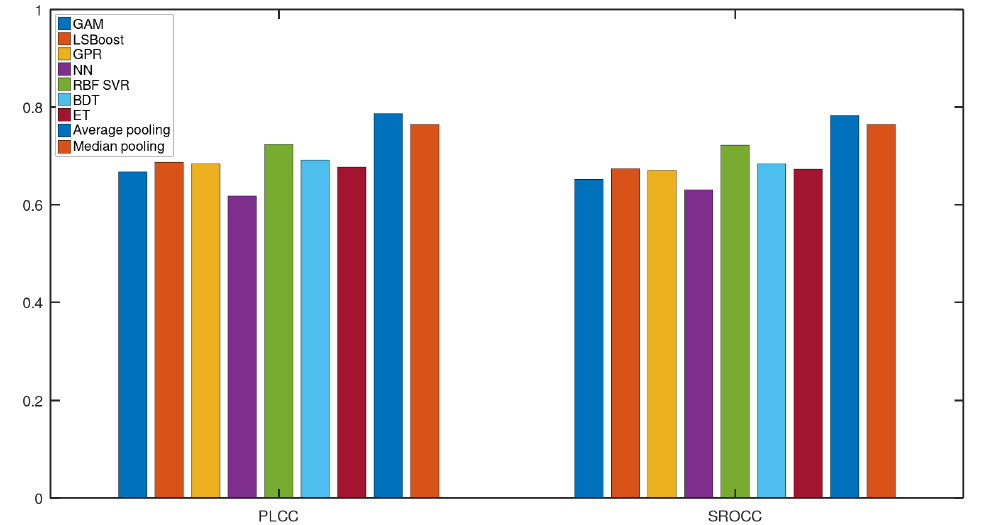
Figure 4. Performance comparison of different regression techniques (GAM, LSBoost, GPR, NN, RBF SVR, BDT, ET) and strategies (average pooling, median pooling) for the combination of individual regressors’ results on KoNViD-1k [16]. The median PLCC and SROCC values, which were measured over 1000 random training–testing splits, are given.